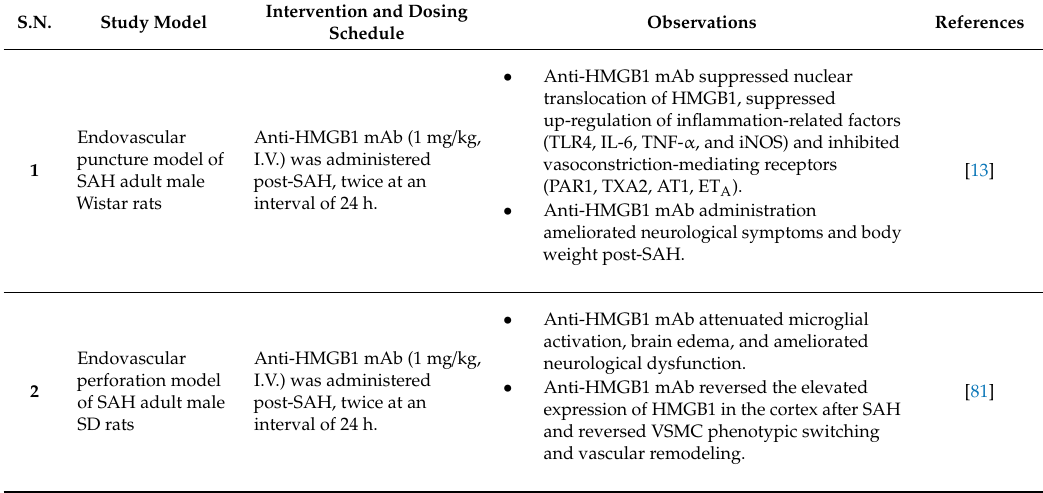
Table 4. Summaries of studies targeting HMGB1 against EBI induced by